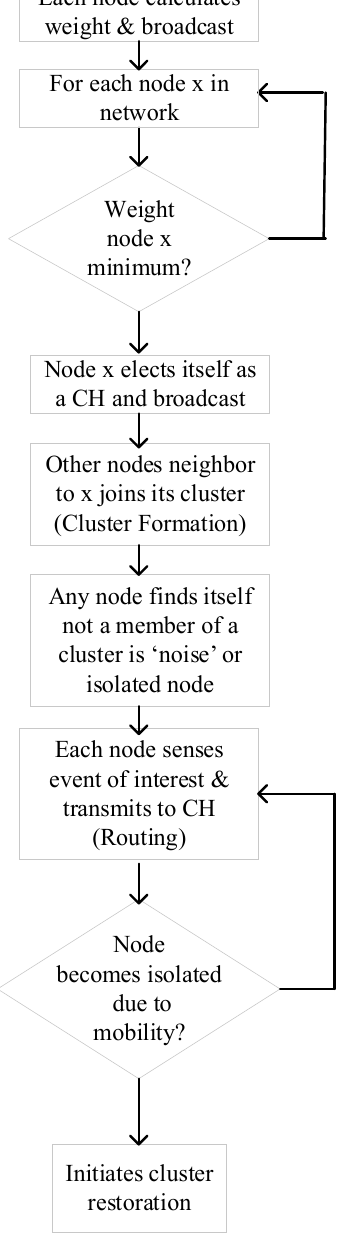
Figure 2. Flowchart of proposed approach.